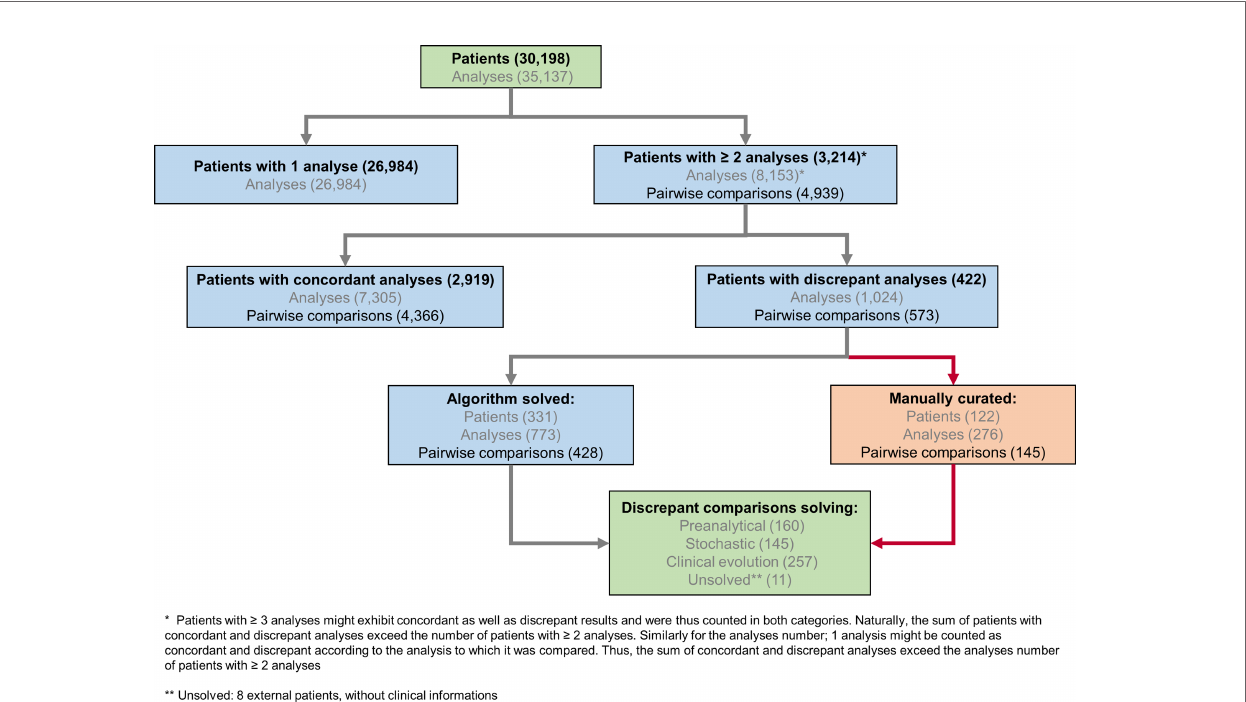
FIGURE 2 | SARS-CoV-2 analytical fl owchart. An R-based script was used to identify 3,214 patients with multiple, potentially discrepant, results (upper part of the chart) and therefore ensure their surveillance. Among these patients with multiple analyzes, 2,792 exhibited only concordant results, while 422 presented at least one discrepant pair of results. Of note, 127 patients had concordant as well as discrepant results; these latter were further processed by the algorithm as patients with discrepant results. When considering 4,939 pairwise comparisons of successive results for patients with multiple tests, 4,366 (88%) were concordant and 573 (12%) were discrepant. The algorithm processed discrepant results further and a potential explanation for the observed discrepancy was attributed either automatically or manually (lower part of the chart and Supplementary Figure S1